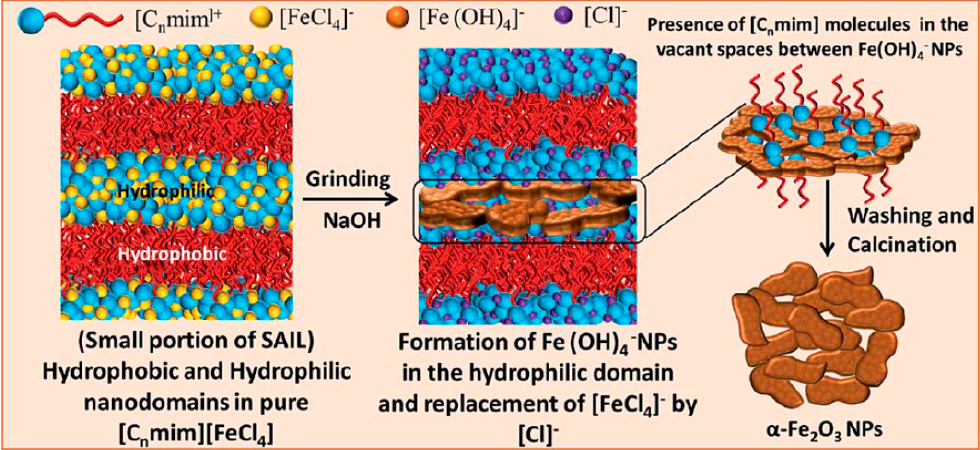
Figure 18. Schematic representation of the role of the nano-segregated polar and non-polar domains of the ionic liquid-based surfactant in the formation of interconnected network of α -Fe 2 O 3 nanoparticles [205]. Reprinted with permission from ref. [205].